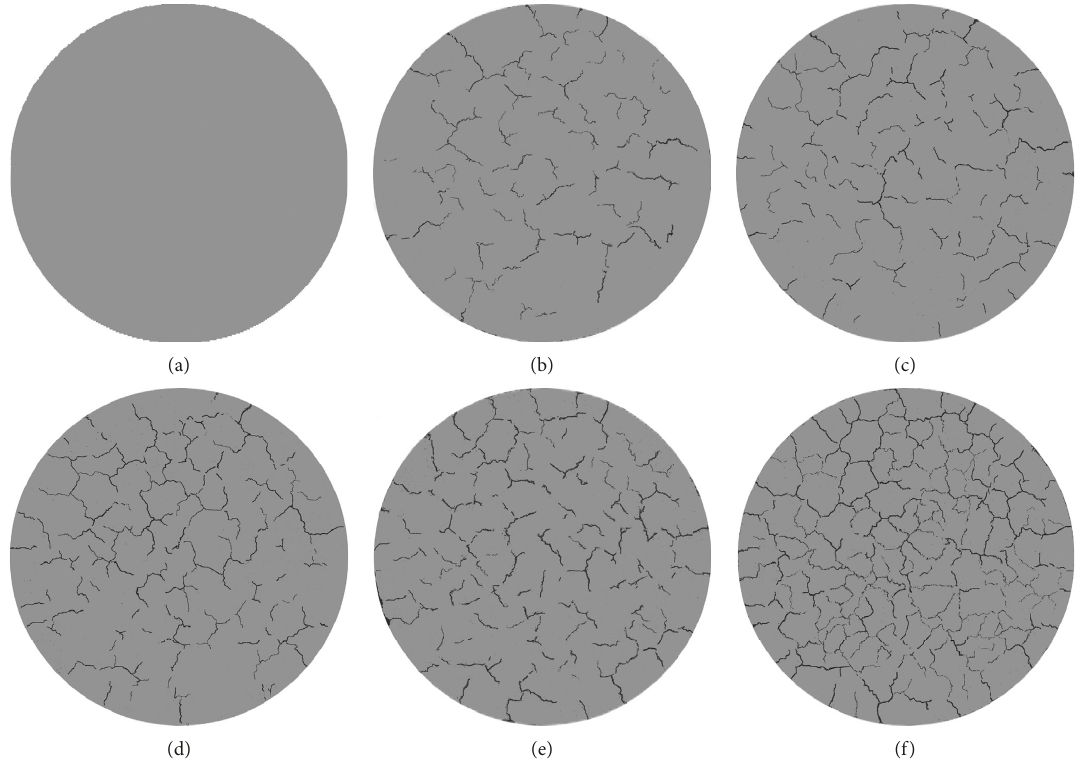
Figure 6: Grayscale images of the cracks on the sample surface after different wetting and drying cycles. (a) Original sample. (b) Cycle one. (c) Cycle two. (d) Cycle three. (e) Cycle four. (f) Cycle